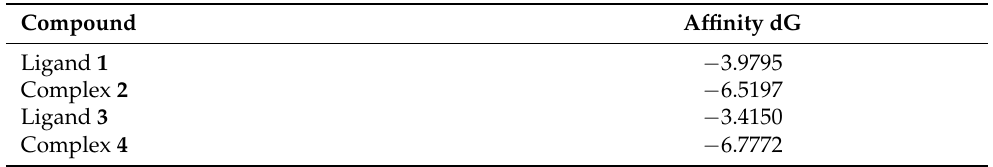
Table 1. The lowest Affinity dG scores of the studied compounds docked in bovine xanthine oxidase